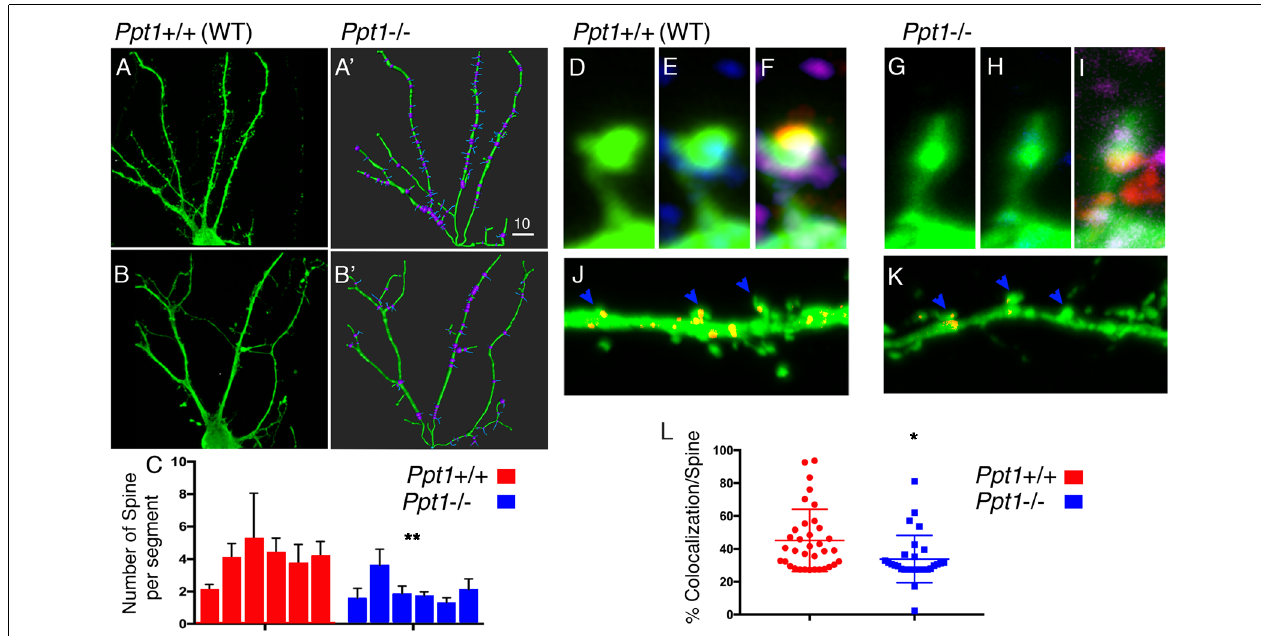
FIGURE 3 | Spine density is modified in Ppt1 − / − cultured hippocampal neurons. (A–C) Hippocampal neurons form control animals (A,A’) or Ppt1 − / − littermates (B,B’) were transfected with GFP and grown for 14 days in culture. Dendrites (green) and dendritic spines (blue) were traced using Imaris Filament Tracer tool (A’,B’) . (C) The numbers of spines branching off dendritic segments were computed from n = 6 cells in each group. Averages of the number of spines per each dendritic segment (branch points are highlighted in purple, see “Materials and Methods” section for details) and SEM are plotted, ∗∗ P = 0.005. (D–L) Hippocampal neurons transfected with GFP (green, D,G ) to mark dendritic spines, and immuno-stained with PSD95 (red, in E,H ) to mark post-synaptic sites and SYNCRIP (SYP) to locate positive puncta along the dendrites. (J,K) SYNCRIP signal (Red) in control or Ppt1 − / − hippocampal neurons, was masked outside the neurons, showing puncta accumulating in the head of control dendritic spines (J) vs. Ppt1 KO cells (K) . (L) Colocalization of SYNCRIP in n = 36 WT and n = 29 Ppt1 KO dendritic spines, was measured and calculated as percentage of the general GFP signal, ∗ P = 0.0101. The Dot plot chart is depicting all measured spines. Lines indicate average